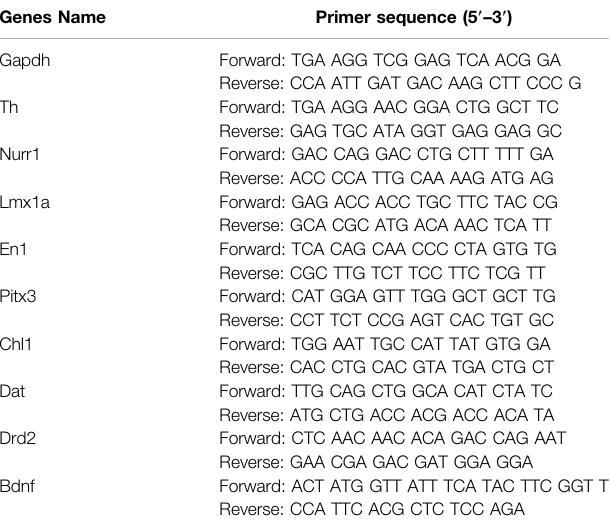
TABLE 1 | Gene-speci fi c primer pair sequences used in the RT – PCR.